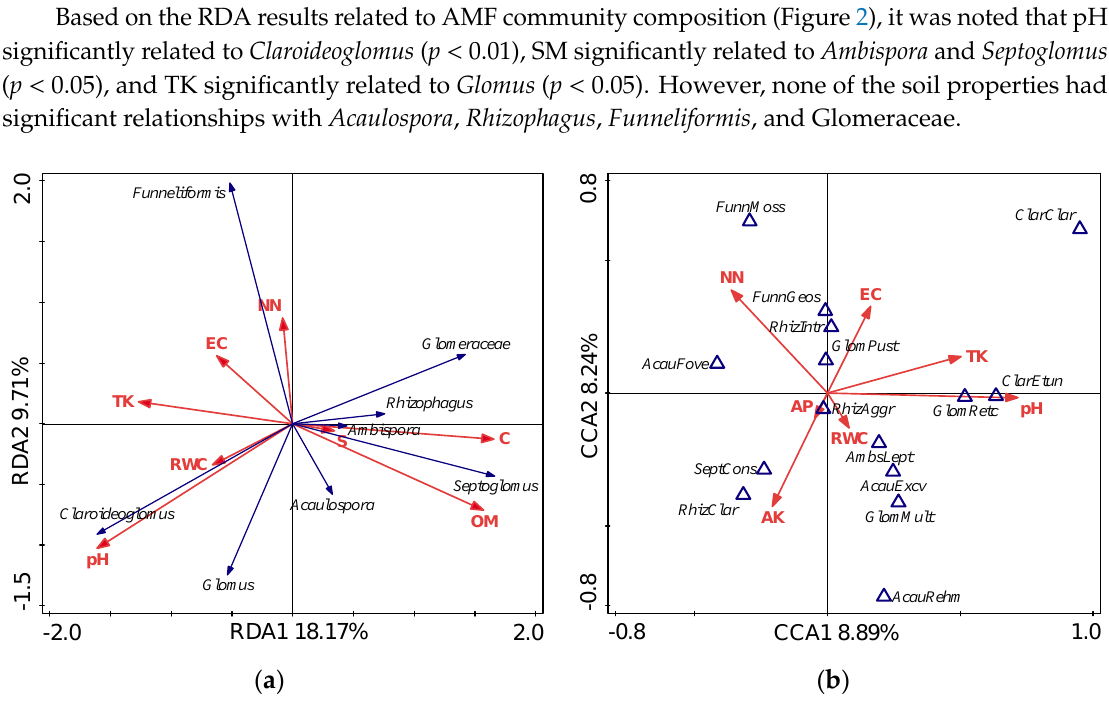
Figure 2. The redundancy analysis (RDA) ( a ) and canonical correspondence analysis (CCA) ( b ) of AMF genera and species with edaphic factors. AcauExcv, Acaulospora excavate ; AcauFove, Acaulospora foveata ; AcauRehm, Acaulospora rehmii ; AmbsLept, Ambispora leptoticha ; ClarClar, Claroideoglomus claroideum ; ClarEtum, Claroideoglomus etunicatum ; FunnGeos, Funneliformis geosporum ; FunnMoss, Funneliformis mosseae ; GlomMult, Glomus multiforum ; GlomPust, Glomus pustulatum ; GlomRetc, Glomus reticulatum ; RhizAggr, Rhizophagus aggregatus ; RhizClar, Rhizophagus clarus ; Rhizintr, Rhizophagus intraradices ; SeptCons, Septoglomus constrictum